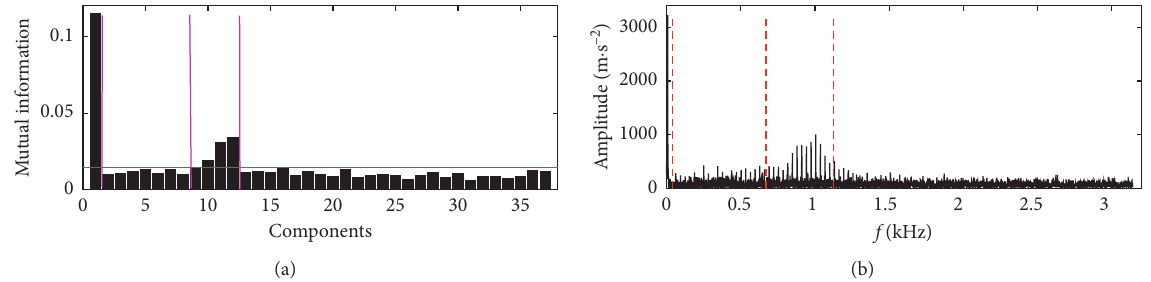
Figure 4: IEWT divides the spectrum. (a) MI of initial components. (b) Redistribution of spectrum.